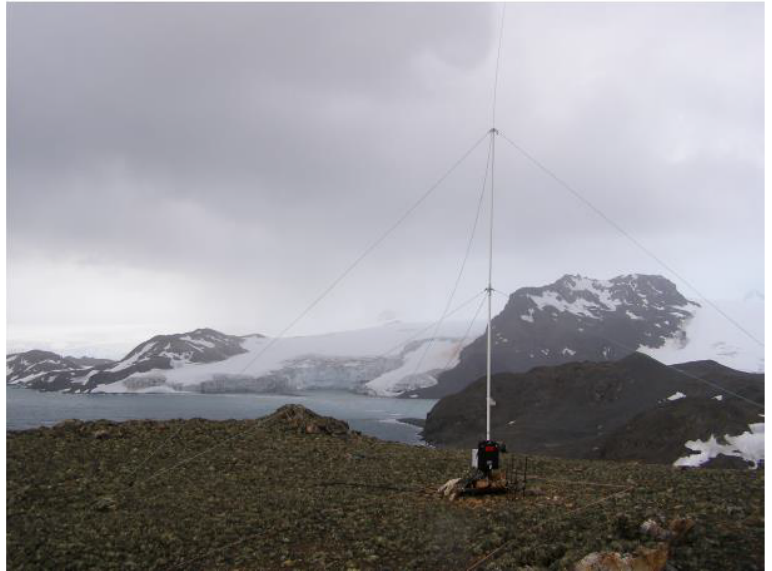
Figure 7. The antenna of the oblique ionosonde transmitter at the